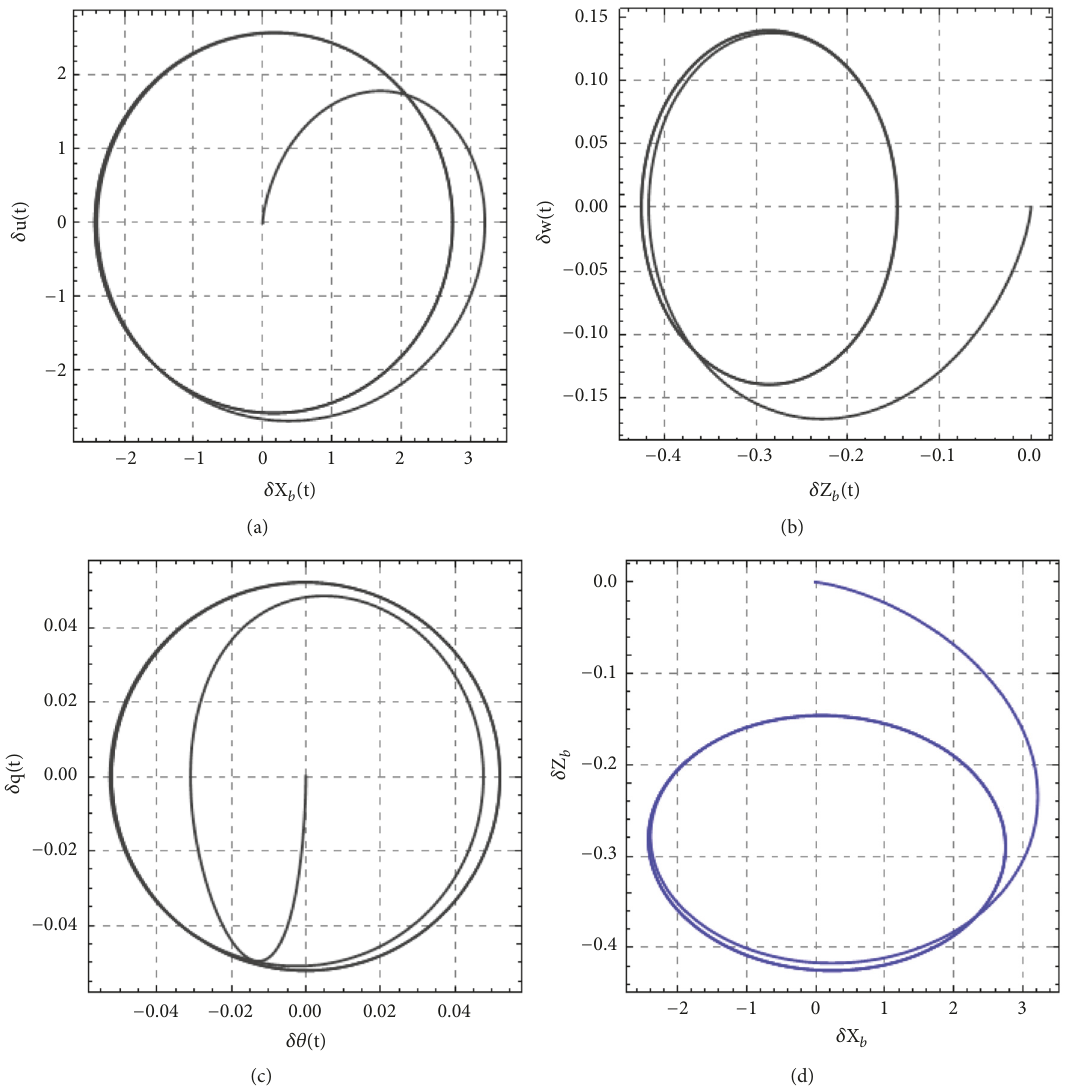
Figure 7: Phase diagram and flight trajectory of the FMAV with its tail vibrating